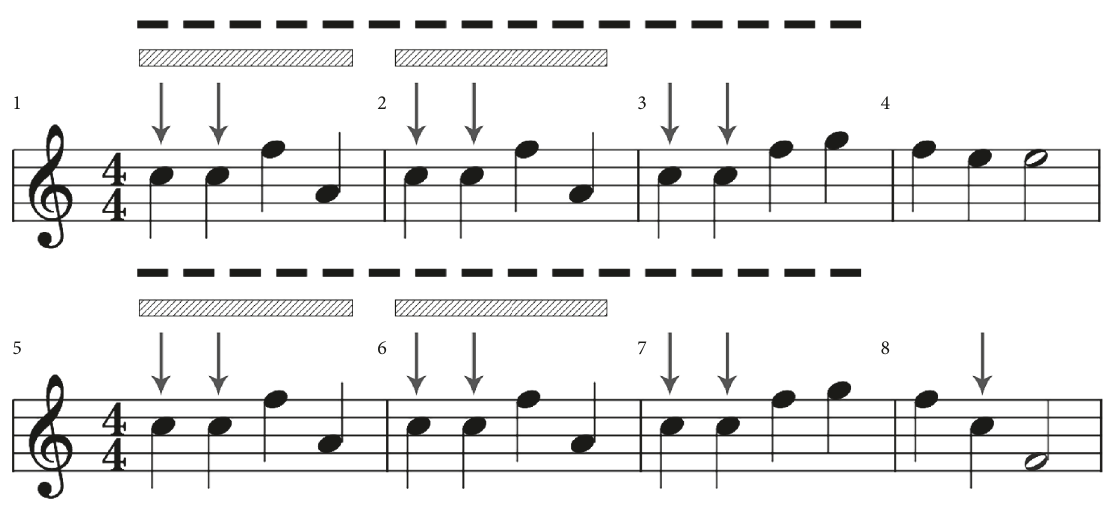
Figure 1: Simple eight-bar musical sequence. Arrows indicate a repeated note, shaded areas indicate a repeated 4-note/1-bar sequence, and the dotted areas indicate a repeated 12-note/3-bar